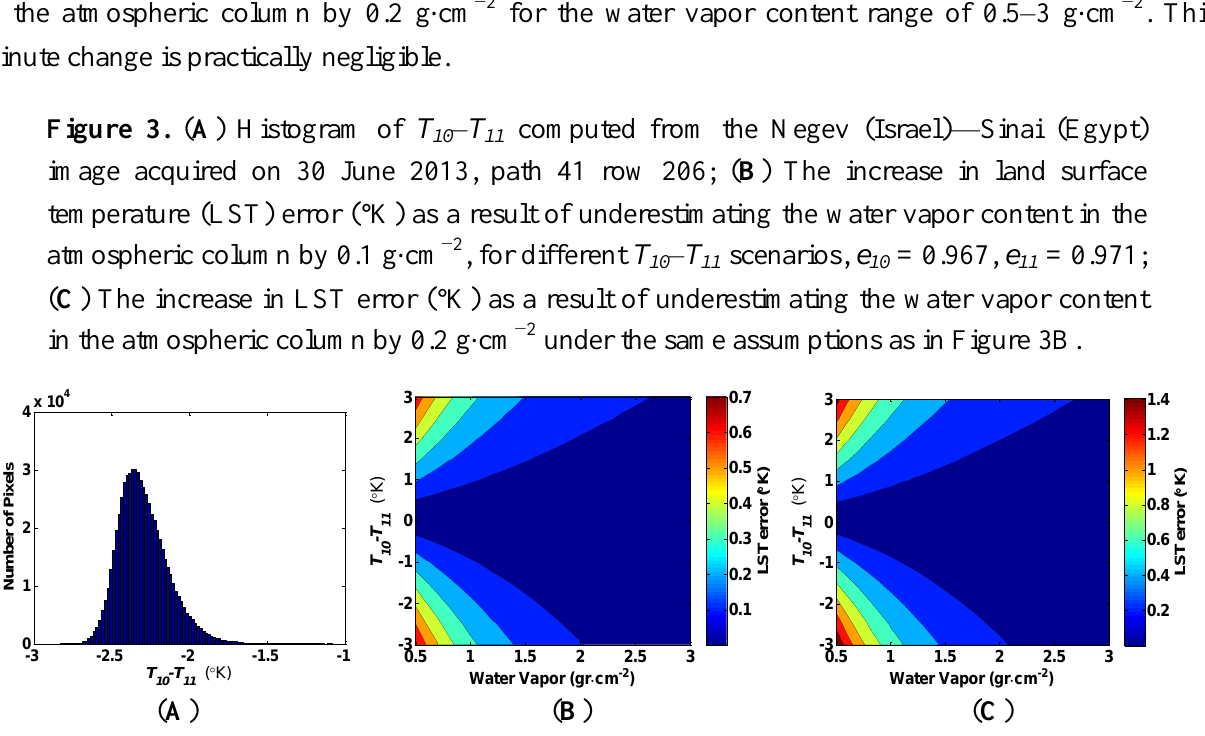
– T computed from the Negev (Israel)—Sinai (Egypt) 10 11 – T scenarios, e = 0.967, e = 0.971; 10 11 10 11